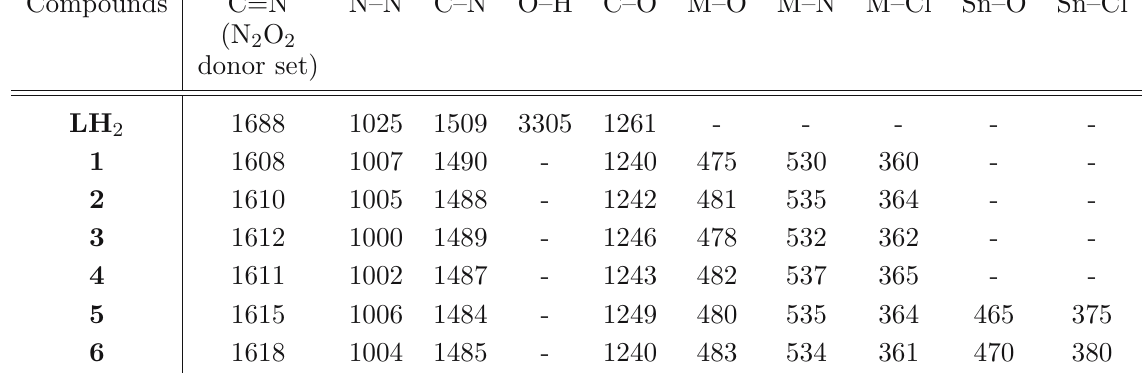
Table 1 IR data for ligand ( LH 2 ) complexes 1 - 6